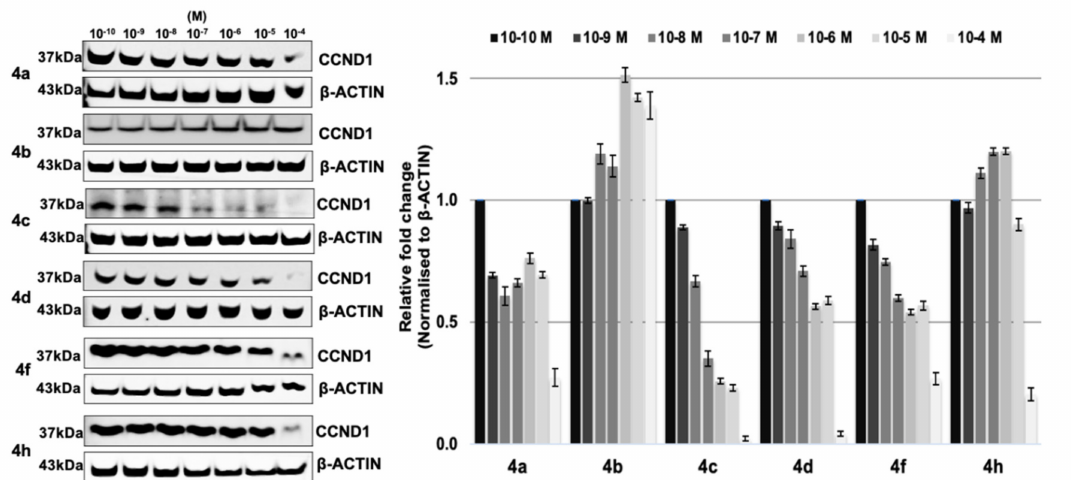
Figure 4. Effect of selected ATBA compounds on the expression of CCND1 in MCF7 cells. Soluble whole-cell extracts were run on an SDS-PAGE and immunoblotted. β -ACTIN was used as input control for cell lysate (left side). The predicted sizes of detected protein bands in kDa are shown on the left side. The average of three independent densitometry analyses of CCND1 and β -ACTIN is shown above (right side) by use of Image J software from NIH, USA (http://imagej.nih.gov/ij/) as described previously